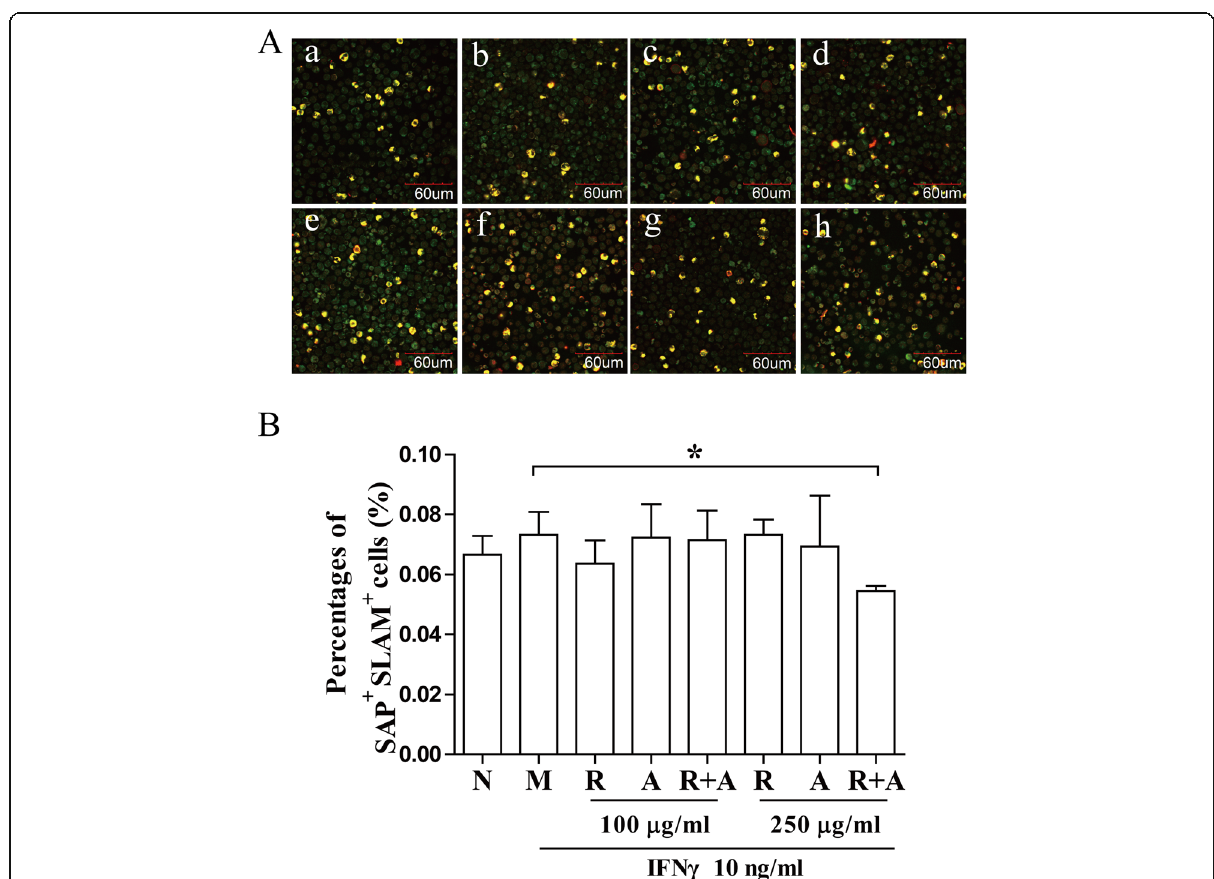
Fig. 6 Regulation of activation of the SLAM/SAP signaling pathway after 24 h of treatment. ( a ) BM cells were stained with CD150/SLAM and SH2D1A/SAP antibodies and observed by confocal immunofluorescence microscopy. The double-stained cells (yellow) were quantified with ImageJ. The scale bar corresponds to 60 μ m throughout. ( b ) The quantified results are presented in a bar chart. a, Normal (N) group; b, Model (M) group; c and f, Radix Astragali (R) group; d and g, Radix Angelicae Sinensis (A) group; e and h, Radix Astragali + Radix Angelicae Sinensis (R + A) group; c, d and e were treated with 100 μ g/mL of freeze-dried powders, and f, g and h were treated with 250 μ g/mL of freeze-dried powders. Data are presented as the mean ± SD, n = 3. * P < 0.05 and ** P <